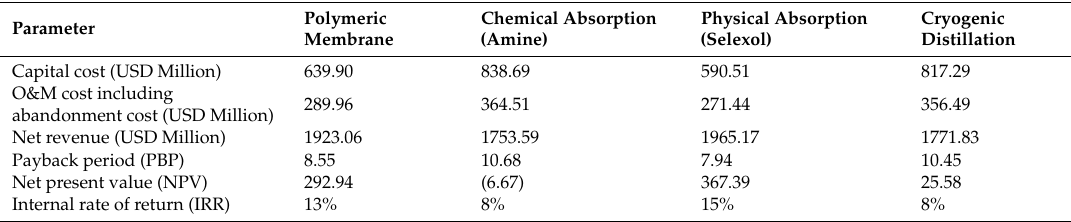
Table 5. Economic results of the base case and the four CO 2 capture